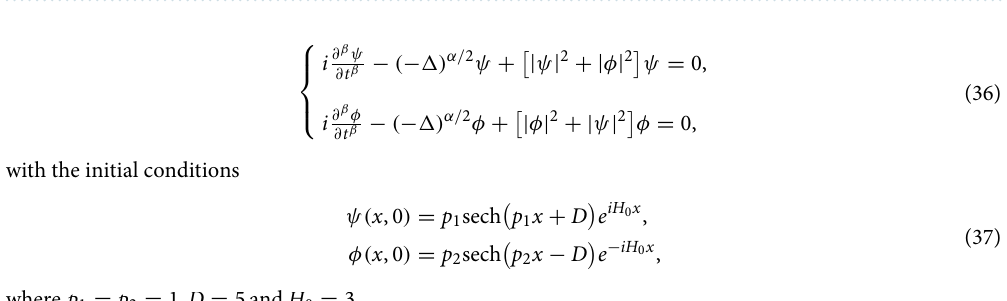
Figure 6. Plots of model (36) for β = 0.3 and α = 1.3